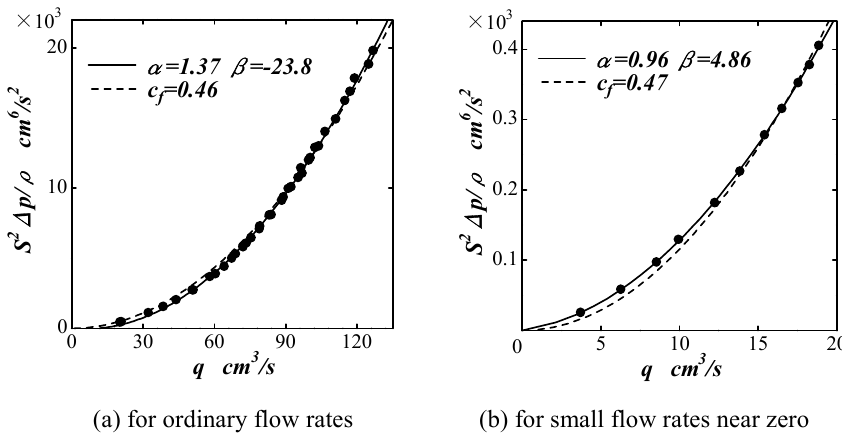
Fig.5 Steady-state characteristics of test